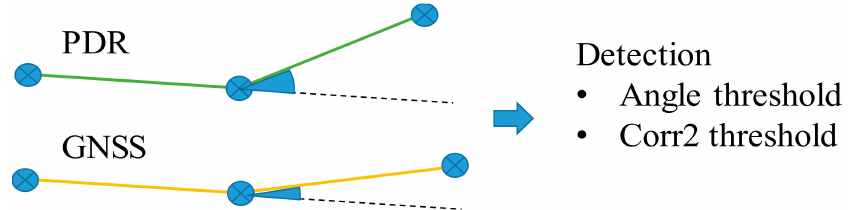
Figure 4. Three points on the PDR and GNSS tracks are taken, with intervals of 5, 10 and 15 m. The angle between the two lines formed by the three points is derived for both tracks. An angle threshold then classifies the GNSS track section as being of good or bad quality. Another method uses the three points and feeds them to the corr2 function in